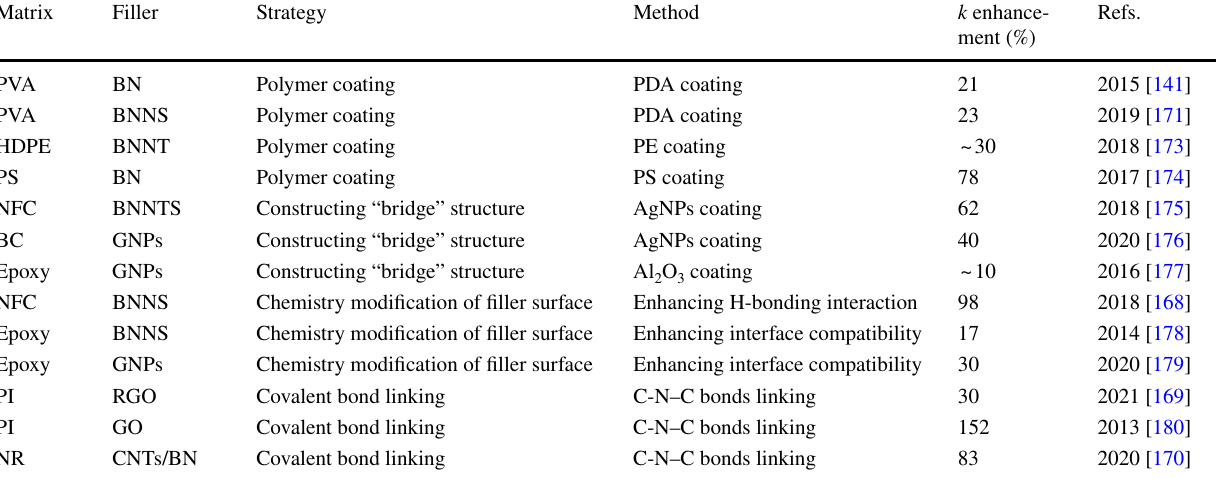
Table 7 The summary of previously reported works to reduce ITR